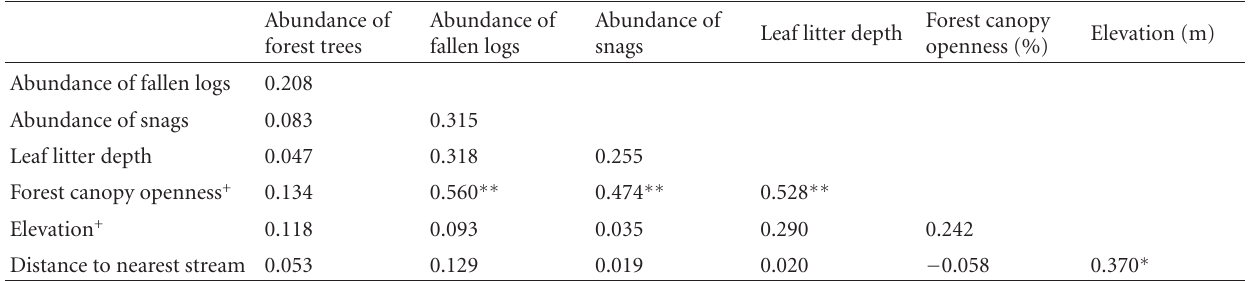
Table 2: Pearson correlation matrix among the forest structure components recorded in 72 plots at the Reserva Florestal Adolpho Ducke, Manaus, central Amazonia, used in the avian community analyses; ∗∗ P < 0 . 001; ∗ P < 0 . 05 resulting from the Bonferroni probability matrix.